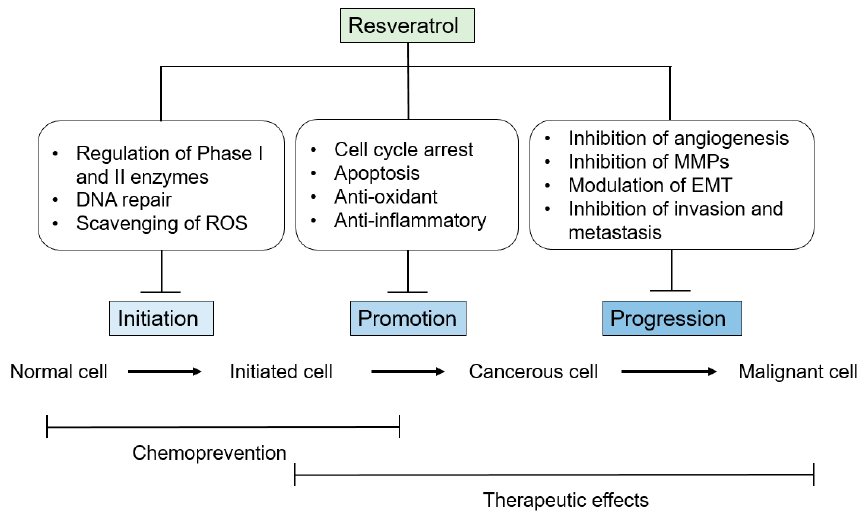
Figure 2. A schematic diagram summarizing the potential mechanism(s) underlying the anticancer effects of resveratrol.